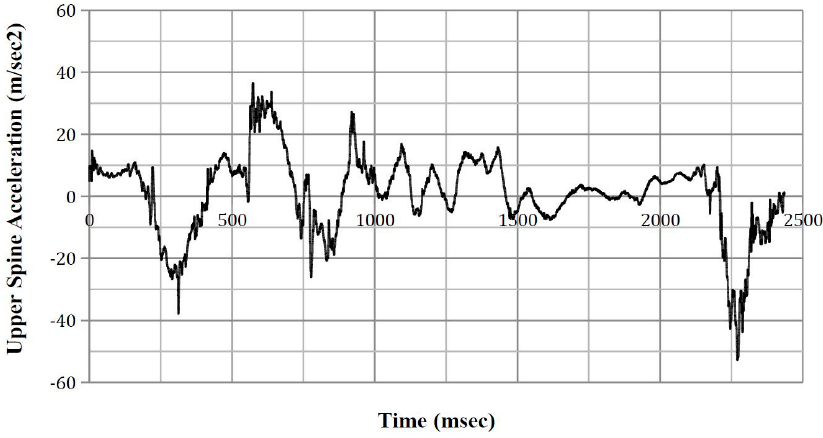
Figure A12. ATD Position 5 upper spine acceleration.